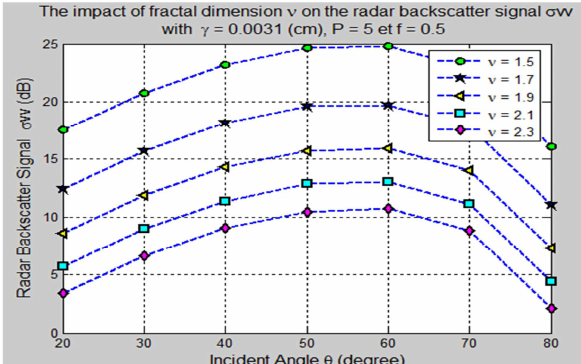
Figure 6. Backscattering coefficient angular trends on fractal parameter ν at VV polarization